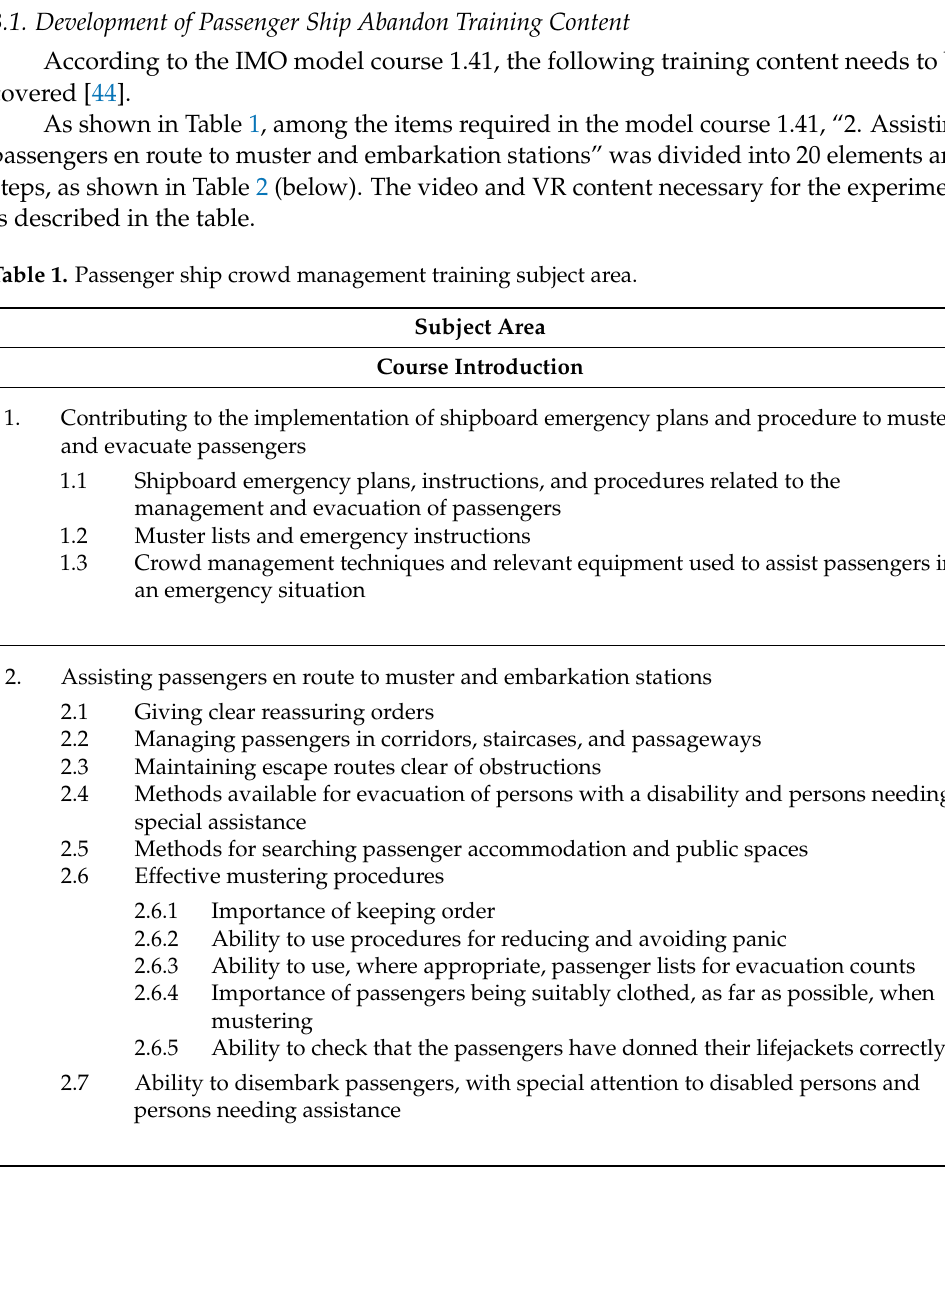
Figure 1. Method and procedure of study.